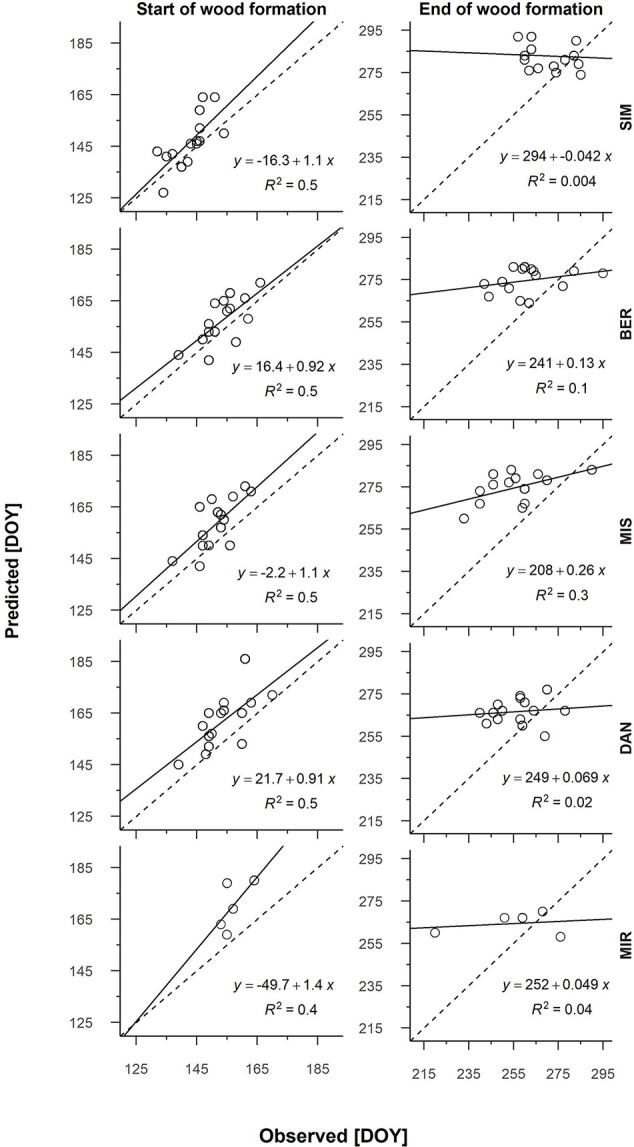
Linear regression of the predicted and observed start and end of wood formation for all sites and years (2002–2016; 2012–2016 for MIR). Each graph has a dashed 1:1 line. Sites are organized along the latitudinal gradient with the southernmost site (SIM) as the top row.